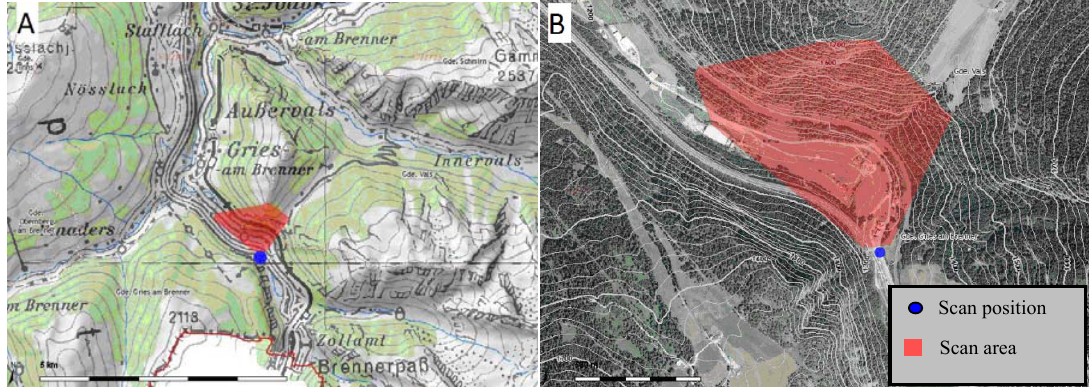
Figure 5. Test are (( A ): ÖK 50; ( B ) aerial photo); image source: © Land Tirol, tiris , www.tirol.gv.at/tiris.